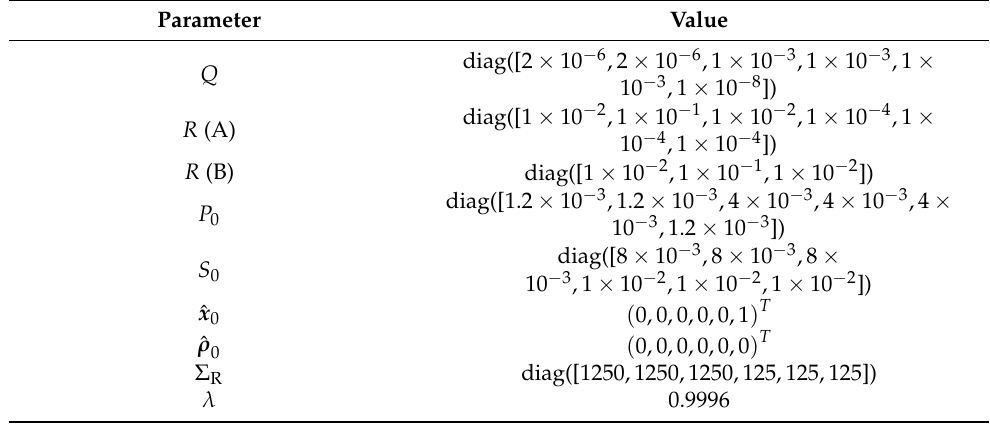
Table 4. Estimator scheme parameter choice, units according to the International System of Units.